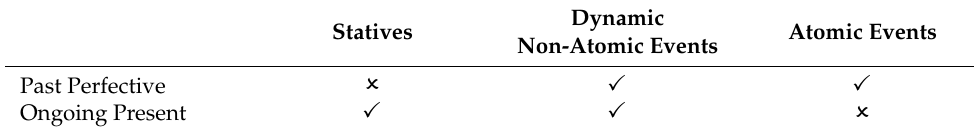
Table 3. Aktionsart and temporal